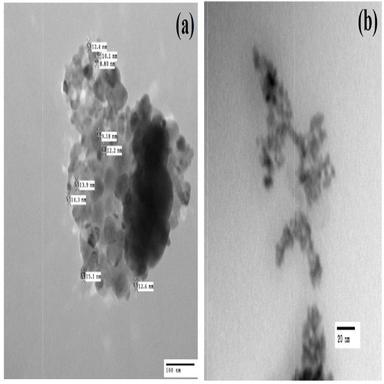
TEM images for 0.5M undoped CdS NP (a) with PVP and (b) without PVP.